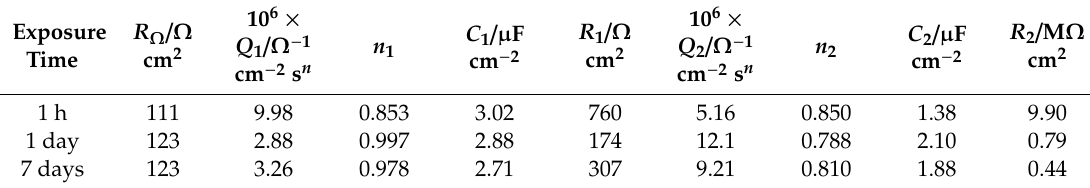
Figure 5. The Bode plots of ( a ) the unmodified Ti-implant and ( b ) the modified Ti-implant recorded at E OC in the artificial saliva electrolyte solution, pH 6.8 after various immersion times denoted. Symbols—the experimental data; solid lines—the modeled data. The schematic presentation of the electric equivalent circuits (EECs) used to fit the spectra of ( c ) the unmodified Ti-implant and ( d ) the modified Ti-implant. Table 2. Impedance parameters calculated for electrochemical impedance spectroscopy (EIS) data of the Ti-implant / oxide film / artificial saliva interface (Figure 5a) recorded at E OC after various exposure times denoted.